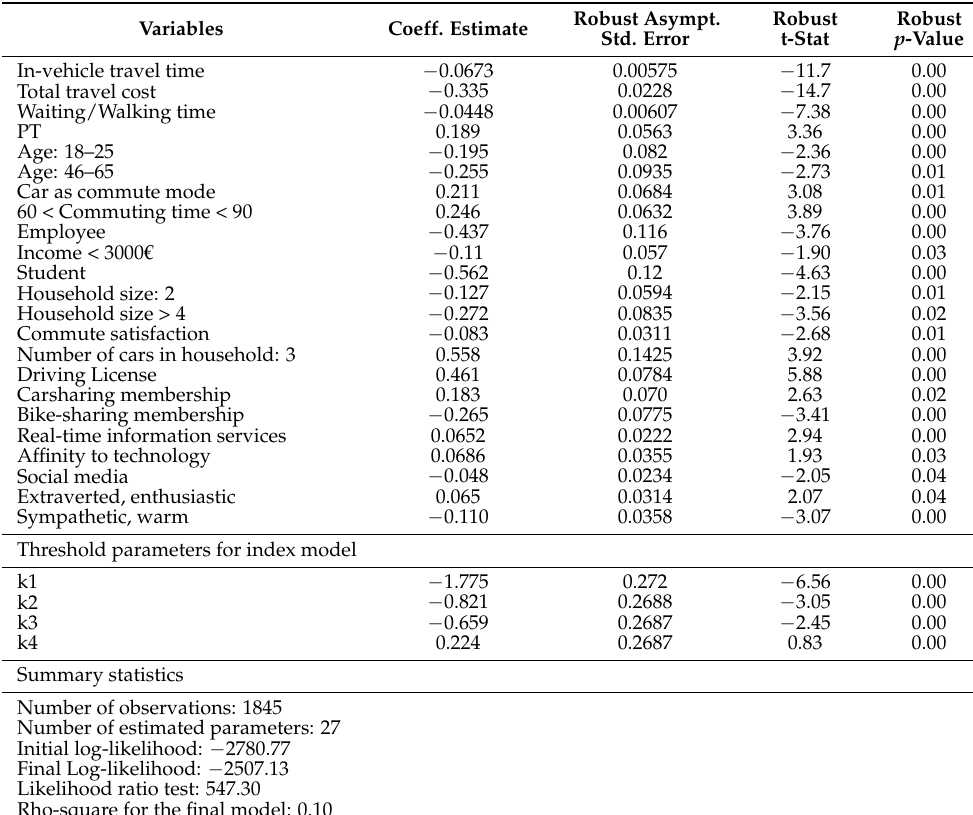
Table 3. Ordered Probit estimation